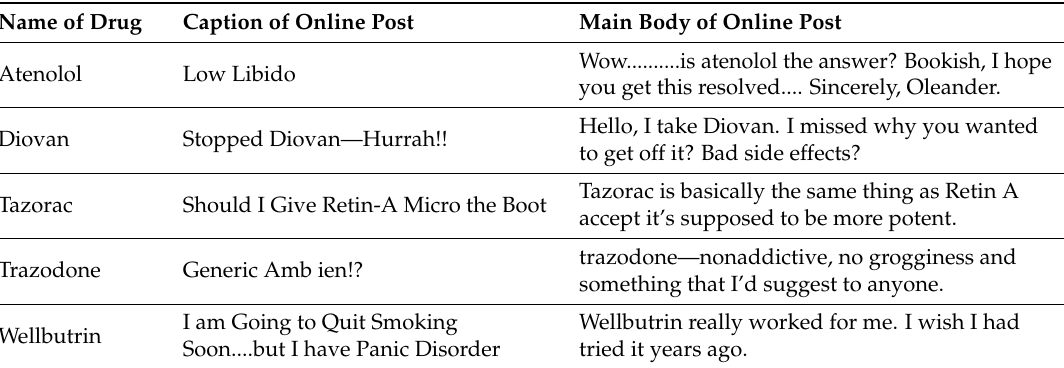
Table 2. Example of posts in online health